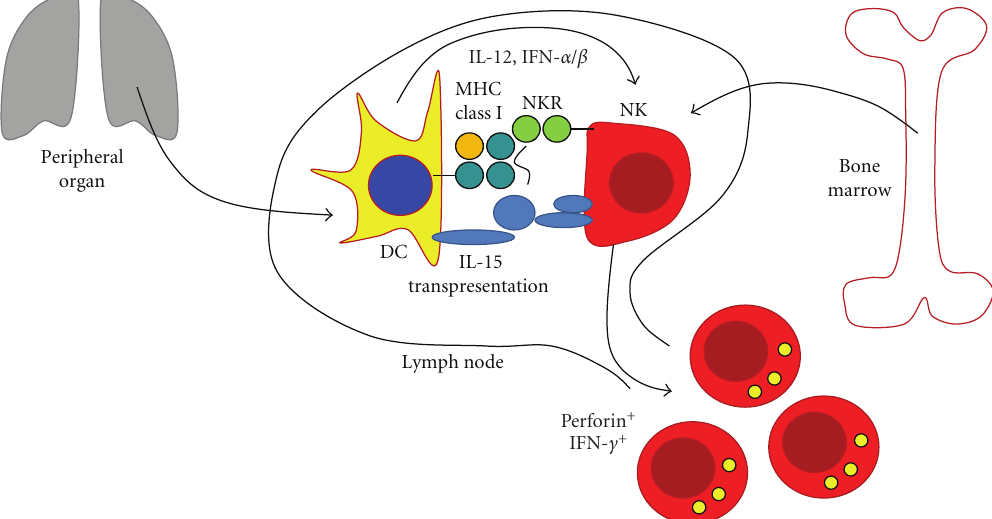
Figure 1: NK-cell preactivation in secondary lymphoid organs by dendritic cells (DCs). Mature DCs preactivate NK cells in secondary lymphoid tissues but are not killed in the process and continue to prime adaptive immune responses. They achieve this by simultaneously transmitting IL-15-dependent activating signals via transpresentation of this cytokine in distinct domains of their synapse with DCs, while inhibiting NK-cell lysis by engaging inhibitory receptors via MHC class I molecules occurs in other domains of the synapse center. In addition, DC-derived IL-12 and type I IFN (IFN- α/β ) increase IFN- γ production and cytotoxicity of conjugated NK cells. NK cells home to these sites after development in the bone marrow, while mature DCs migrate there at increased frequency from peripheral tissues after their